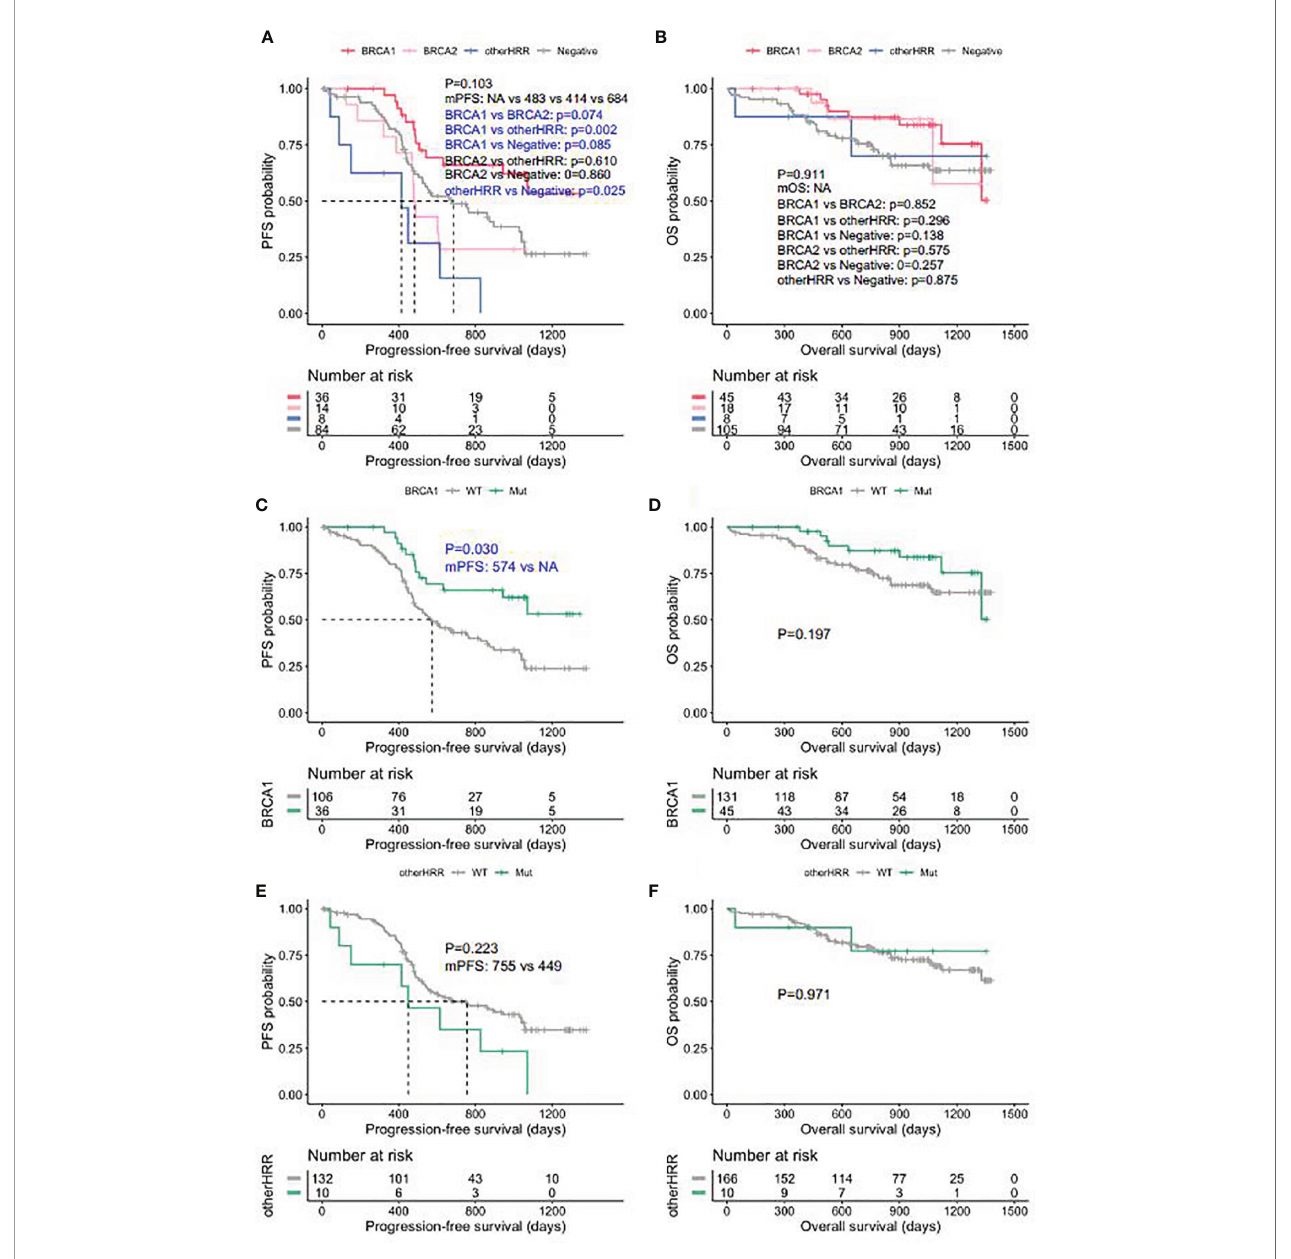
FIGURE 5 | Progression-free survival (PFS) and overall survival (OS) in ovarian carcinoma patients by HRR mutation category. (A) PFS between deleterious BRCA1 , BRCA2 , non-BRCA HRR, and without HRR mutation carriers. (B) OS between deleterious BRCA1 , BRCA2 , non-BRCA HRR, and without HRR mutation carriers. (C) PFS with and without deleterious BRCA1 mutations. (D) OS with and without deleterious BRCA1 mutations. (E) PFS with and without non-BRCA HRR mutations. (F) OS with and without non-BRCA HRR